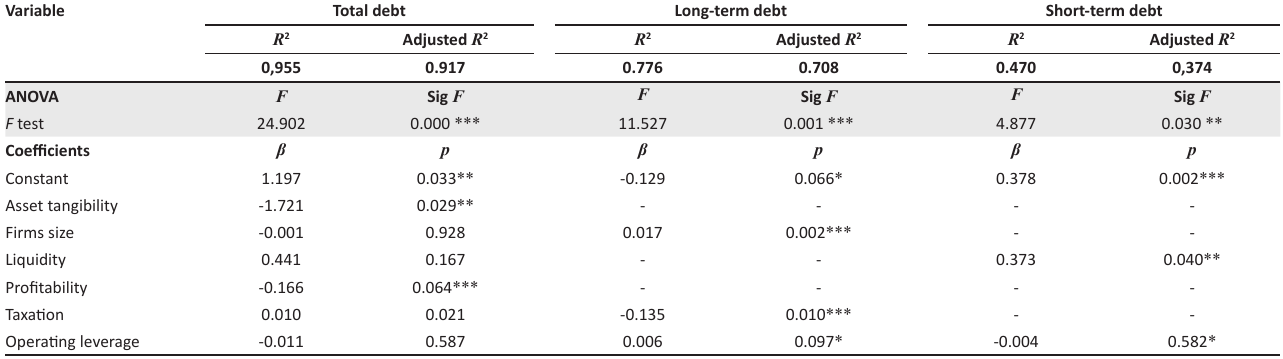
TABLE 5: Multiple regression coefficients: Summary: Total sample (1994–2007). Variable